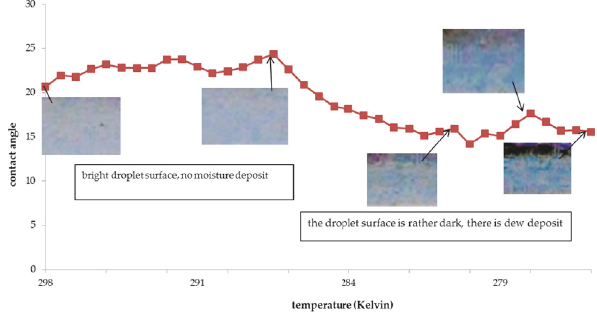
Figure 3: Contact angle of jatropha oil vs.